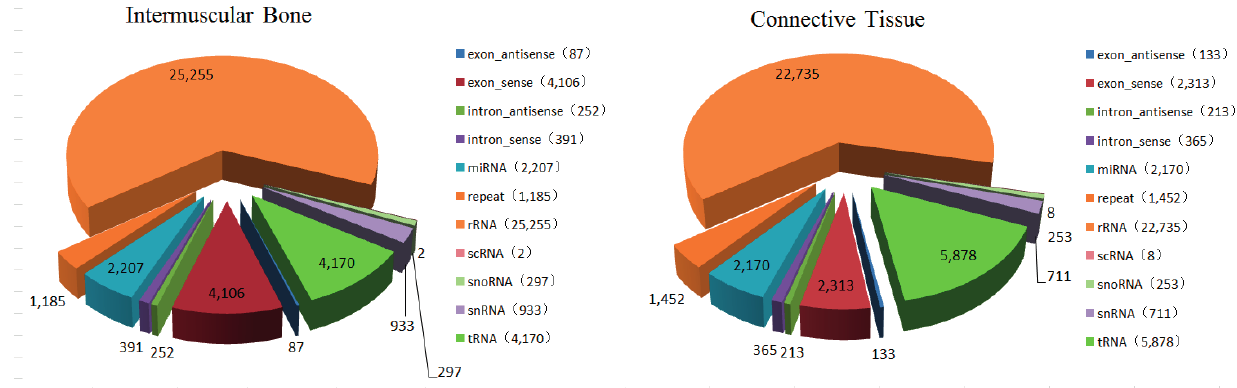
Figure 1. Length distribution of small RNAs in intermuscular bone and connection tissue of M. amblycephala .